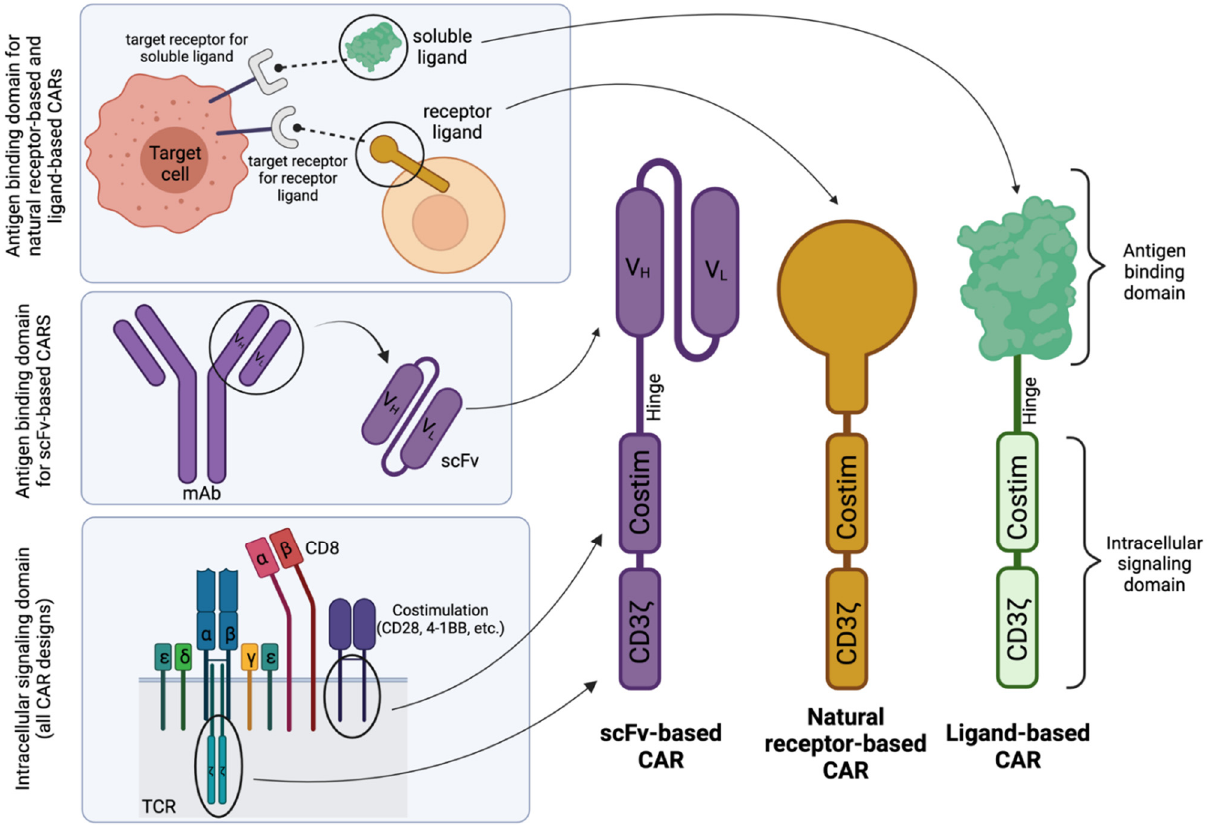
Figure 1. Schematic structures of scFv-based, natural receptor-based, and ligand-based CAR designs. Generally, the intracellular signaling domain is derived from components of the T-cell receptor (TCR). The antigen-binding domain for scFv-based CARs is derived from a single-chain variable fragment (scFv) from a monoclonal antibody (mAb) specific for a target receptor, whereas for natural receptor- or ligand-based CARs, the antigen-binding domain is derived from the receptor or soluble ligand whose natural binding partner is the target receptor. The complementary DNA (cDNA) that encodes the entire protein sequences of each domain or specific binding portions of the ligand or receptor are then cloned into an expression cassette for optimal CAR expression in ex vivo cultured immunocompetent cells. Costim; Costimulation. V H ; Variable heavy. V L ; Variable light. Created with BioRender.com.